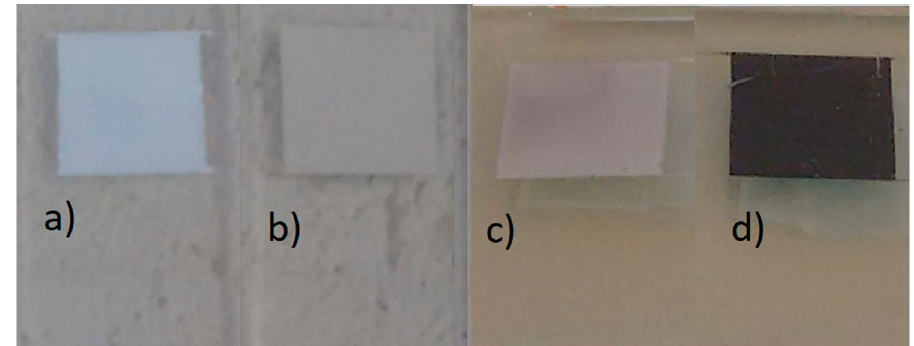
Figure 4. Photographs of FTO glass substrates coated with the semiconductor: ( a ) ZnO-C without dye; ( b ) ZnO-B without dye; ( c ) ZnO-C with dye; ( d ) ZnO-B with dye.